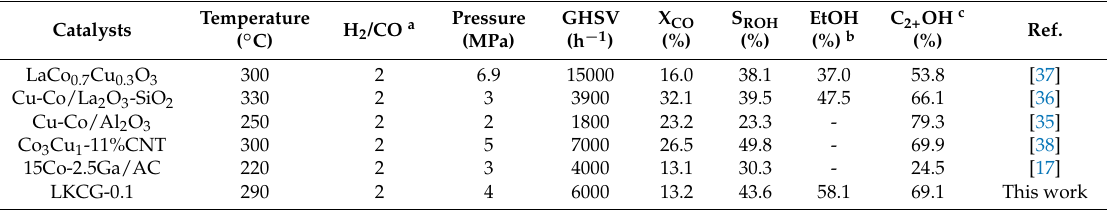
Table 5. Performance of CO hydrogenation reported in the literature.